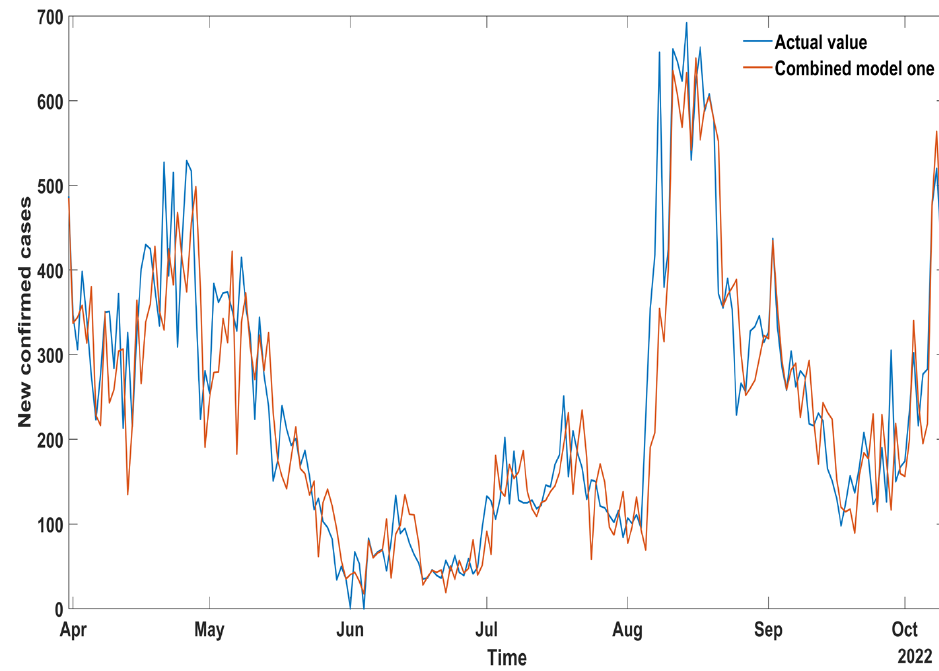
Figure 4. A comparison of combined. Table 2. Regression